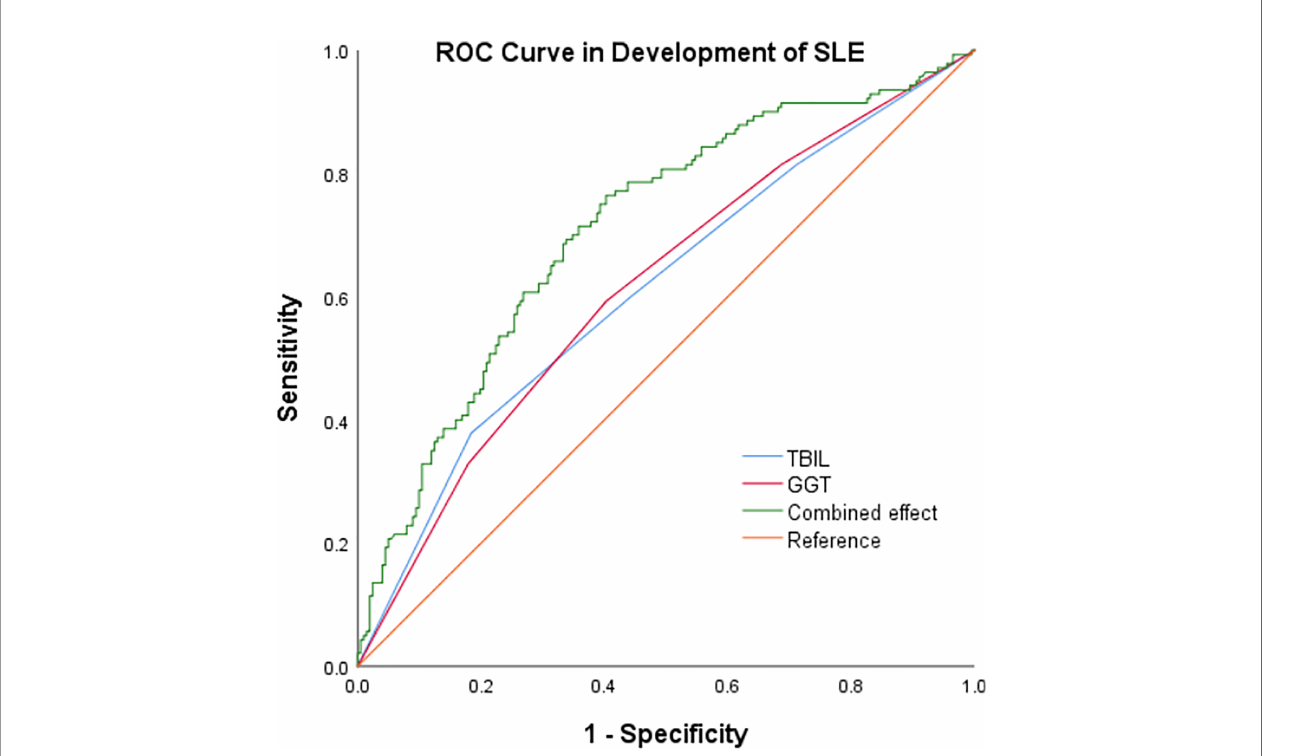
FIGURE 3 | ROC curve of TBIL, GGT and the combined effect in development of